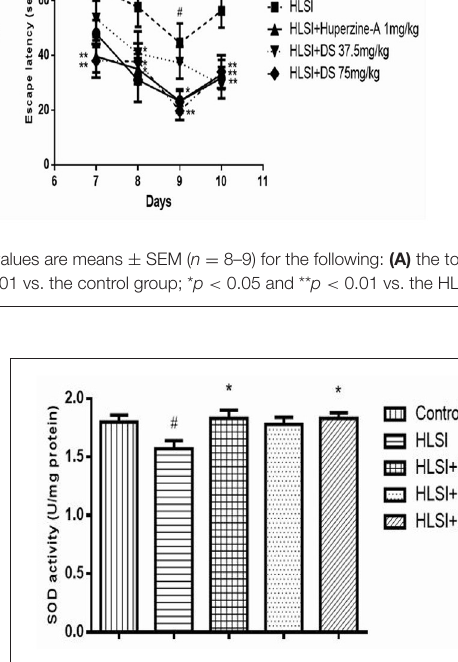
FIGURE 13 | The effect of DS on SOD activity in the hippocampus of rats. All values are means ± SEM ( n = 6). The symbols represent: # p < 0.05 vs. the control group; * p < 0.05 vs. the HLSI